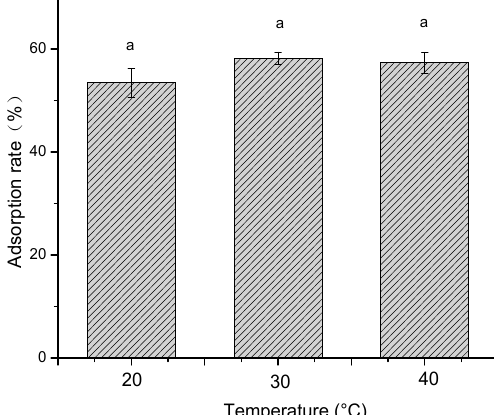
Figure 7. Adsorption efficiency of polyphenols from distiller’s grain using D101 resin (3 g) at different temperatures of 20 °C, 30 °C, and 40 °C under 120 rpm for 24 h. Values with the same letter a differ insignificantly ( P < 0.05) per Duncan’s multiple range test. Vertical bars represent the standard deviation of each value.